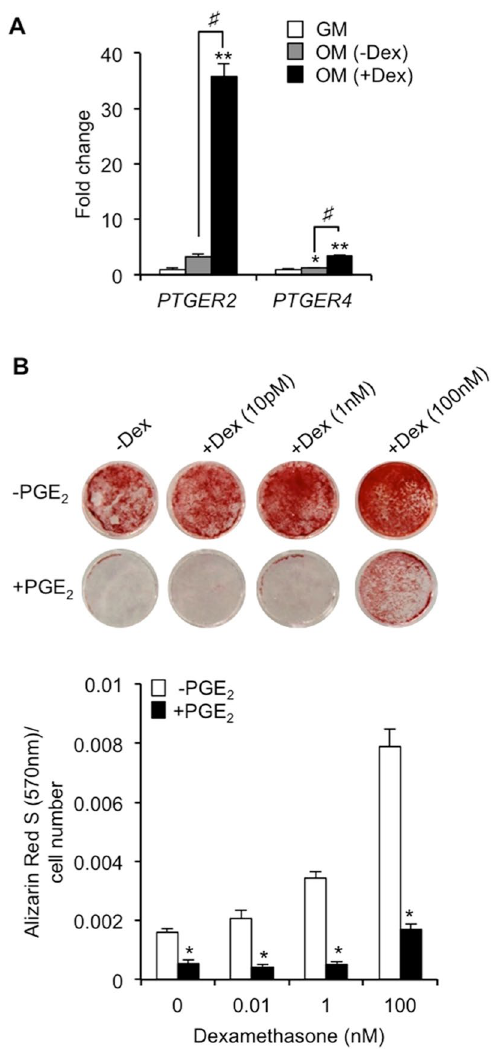
Figure 5. Inhibitory effects of PGE 2 on hBMSC-mediated matrix mineralization are independent of dexamethasone. ( A ) hBMSC were cultured in growth medium (GM), or osteogenic medium (OM) supplemented with ( + Dex) or without ( − Dex) dexamethasone, and PTGER2 and PTGER4 gene expression levels determined at day 10 using RT-qPCR. * p < 0.05, ** p < 0.001 as compared to GM; # p < 0.001 as compared to OM ( − Dex) using ANOVA. ( B ) The effect of continuous PGE 2 (10 nM) treatment on hBMSC-mediated matrix mineralization in the presence or absence of dexamethasone was determined at day 15 by Alizarin Red S staining. * p < 0.001 as compared to untreated hBMSCs ( − PGE 2 ) using Student’s t-test. The data represent triplicate determinations and were replicated at least two times. All values are presented as mean ±